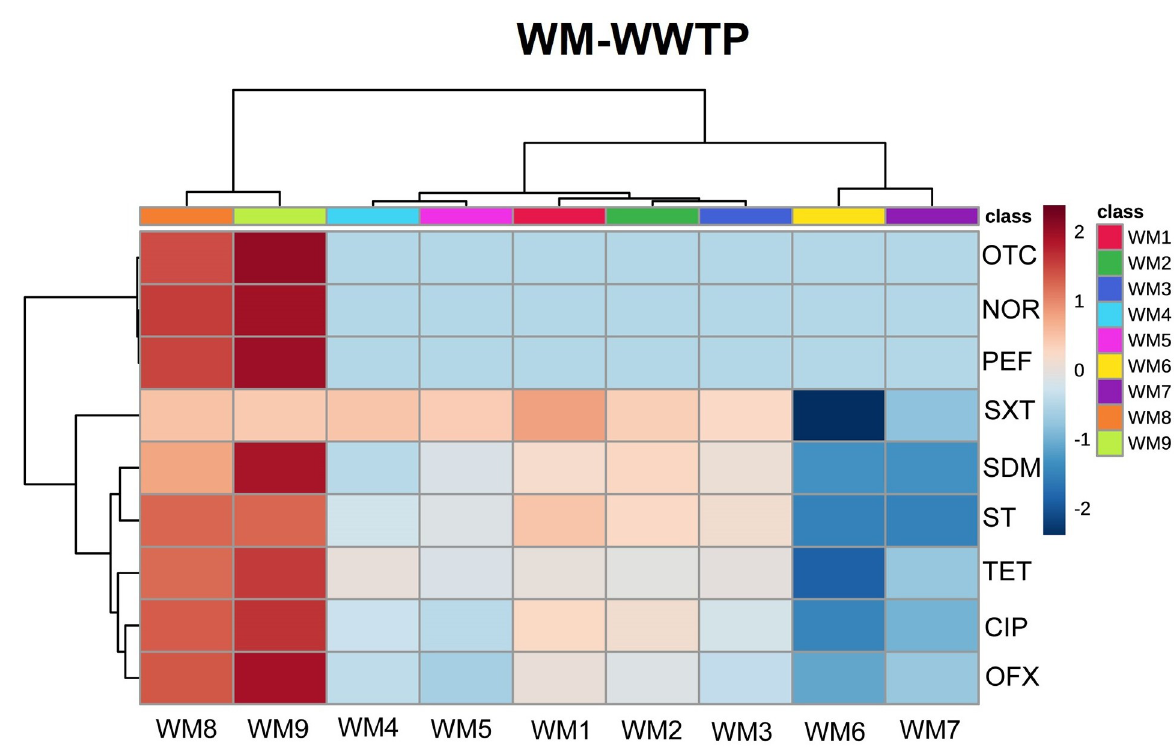
Fig 1. Heatmap of normalized concentrations of antibiotics in different sampling points of WM-WWTP. Red colour indicates high concentration, whereas blue colour low concentration.